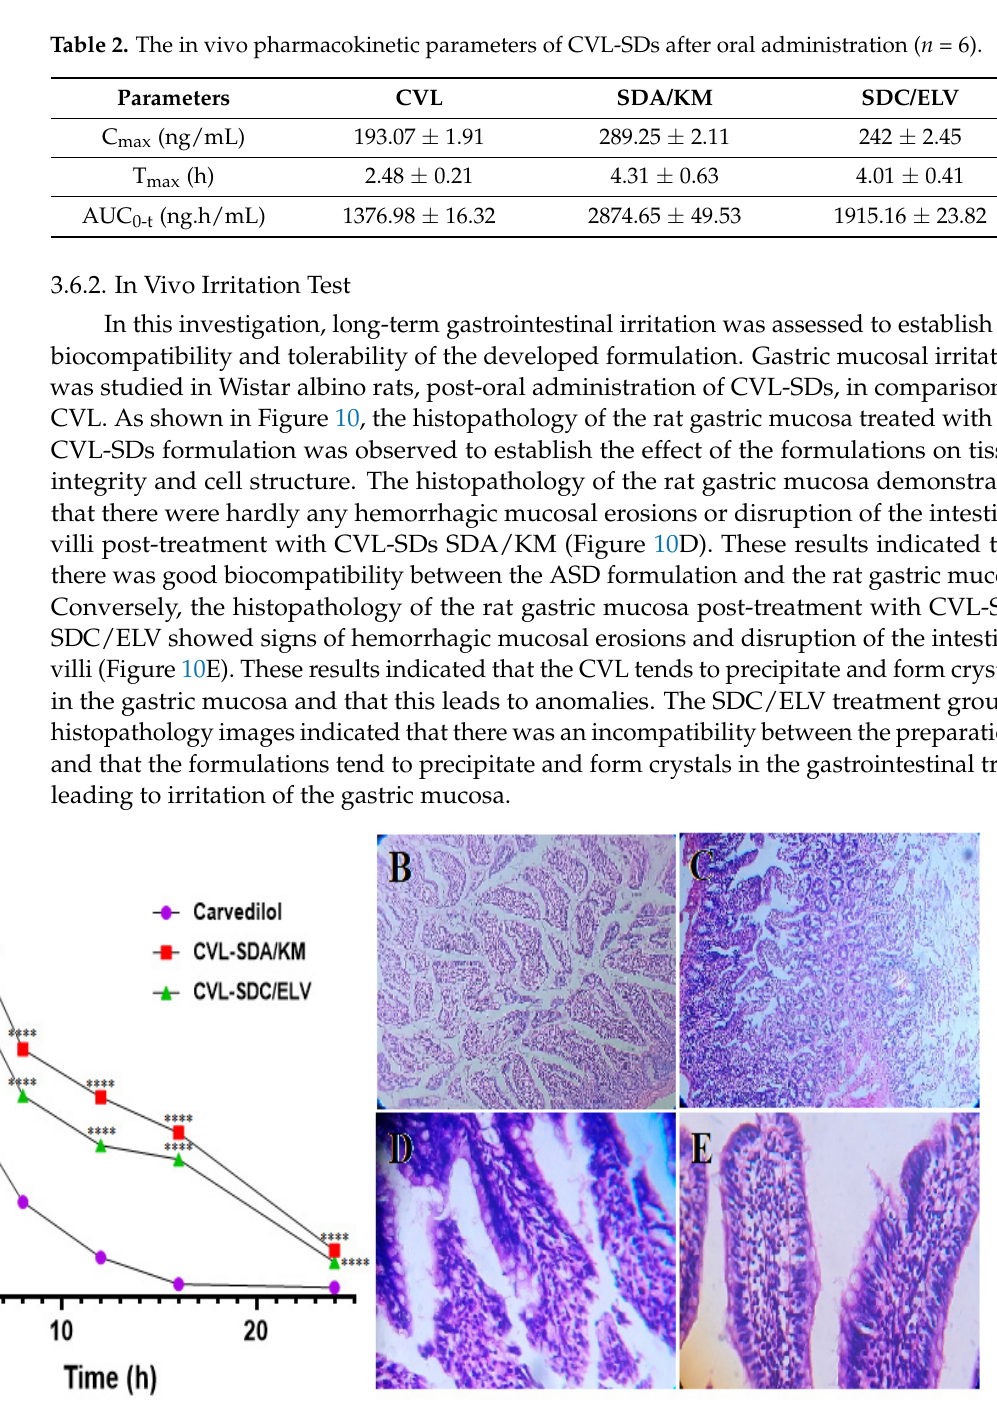
Figure 10. The oral kinetics profiles of the CVL-SDs ( A ) and the histopathological images of the rat duodenum cross-section of the control group ( B ), CVL group ( C ), SDA/KM group ( D ), and SDC/ELV group ( E ). (Data expressed as mean ± SD, n = 3; ns—non-significant, * p < 0.05, ** p < 0.01, *** p < 0.001, **** p <